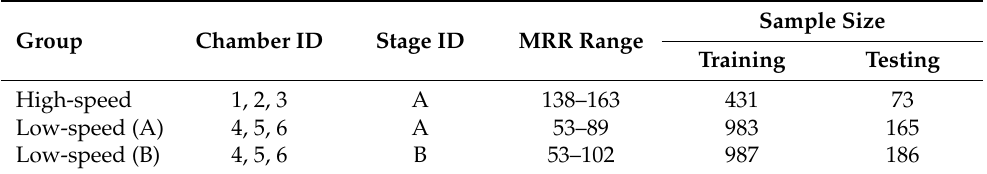
Table 1. Segmentation information and sample size for each group in which the unit for the MRR range is nm/min.